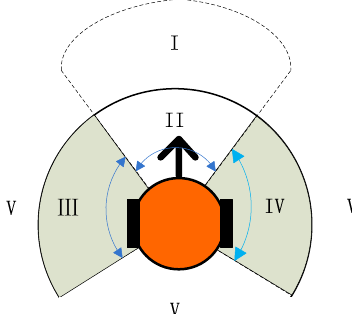
Figure 11. The surrounding area division for collision